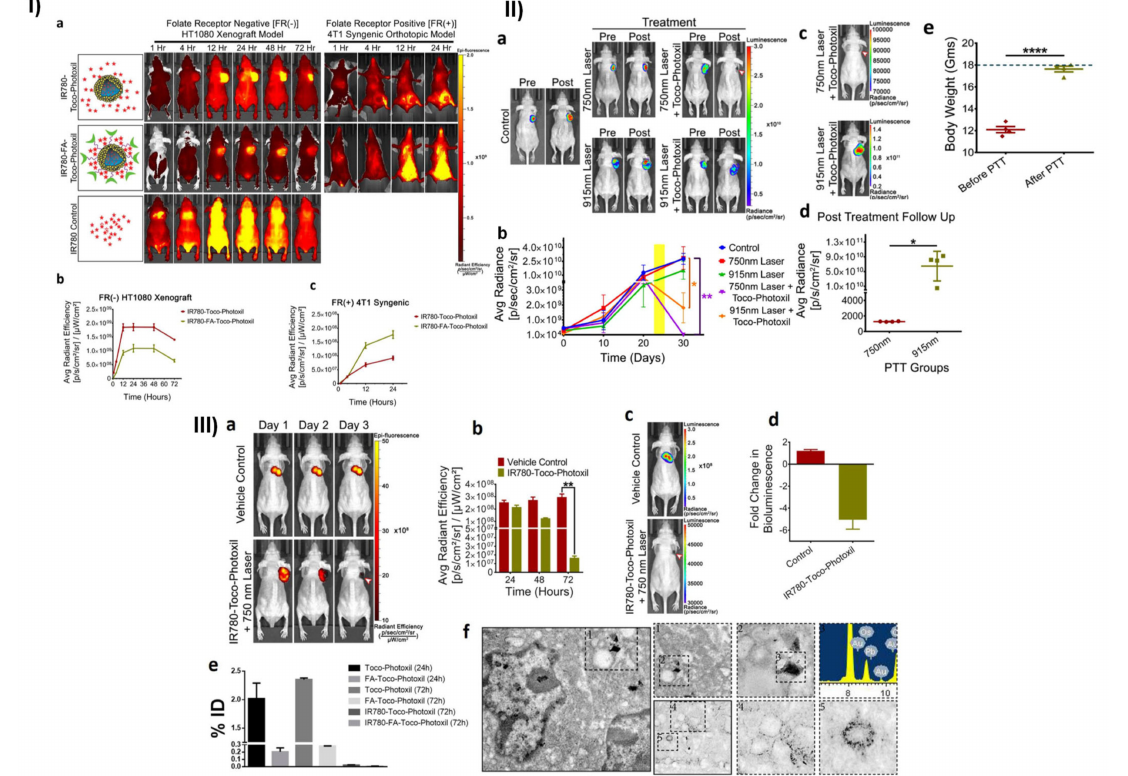
Figure 8. ( I ) ( a ) Near-Infrared Fluorescence (NIRF) imaging in tumor-bearing mice; ( b , c ) Quanti- tative assessment of fluorescence. ( II ) ( a ) In vivo bioluminescence imaging of tumor-bearing mice; ( b ) Bioluminescence signal quantification as an indicator of therapeutic success; ( c ) Bioluminescent pictures of mice after therapy; ( d ) Bioluminescence signal quantification; ( e ) Body weight before